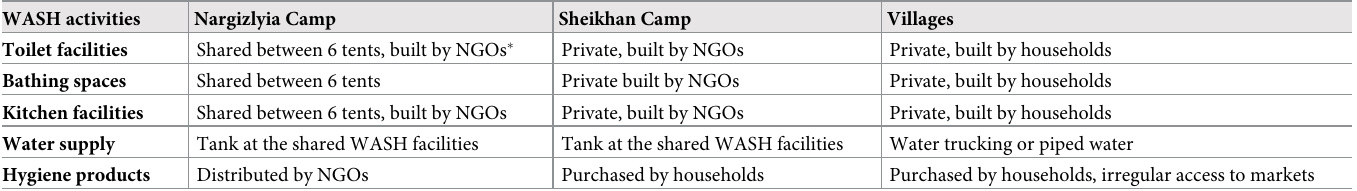
Table 1. WASH characteristics informing the selection of the three research